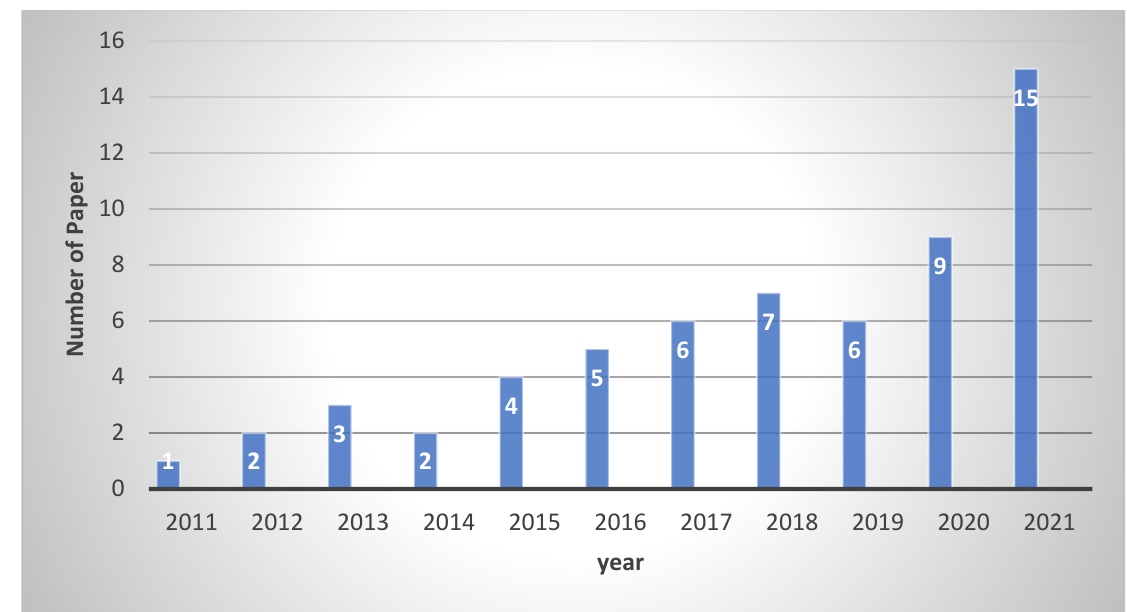
Figure 4. Number of papers in references.